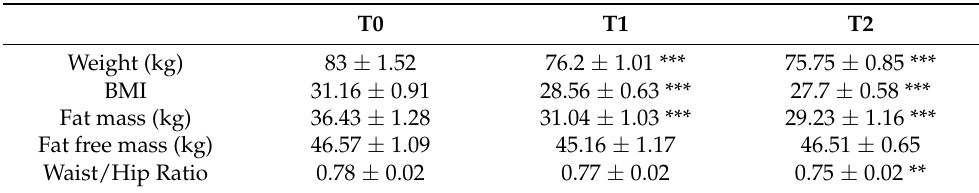
Table 2. Body composition outcomes recorded at baseline (T0), after 5–7 weeks (T1) and